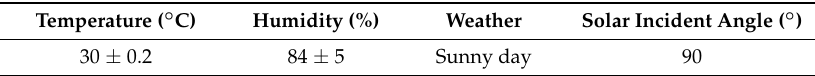
Table 4. Environmental data of sunshine experiment.